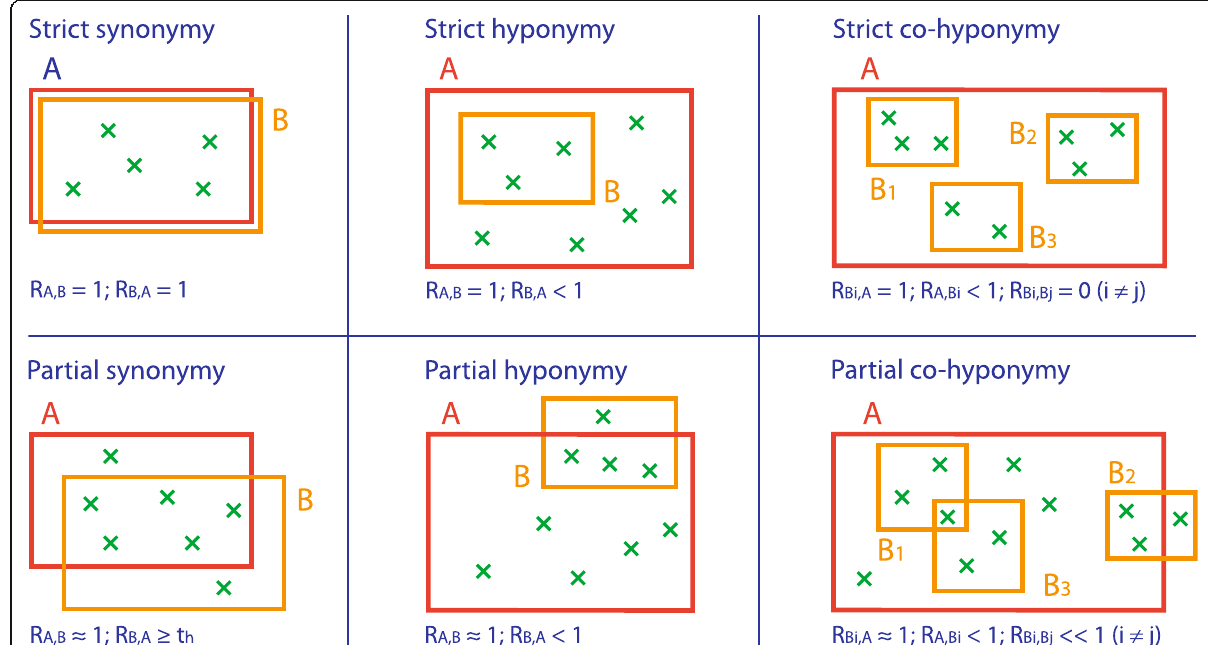
Fig. 12 Euler diagrams showing synonymy, hyponymy, and co-hyponymy for the set-based approach